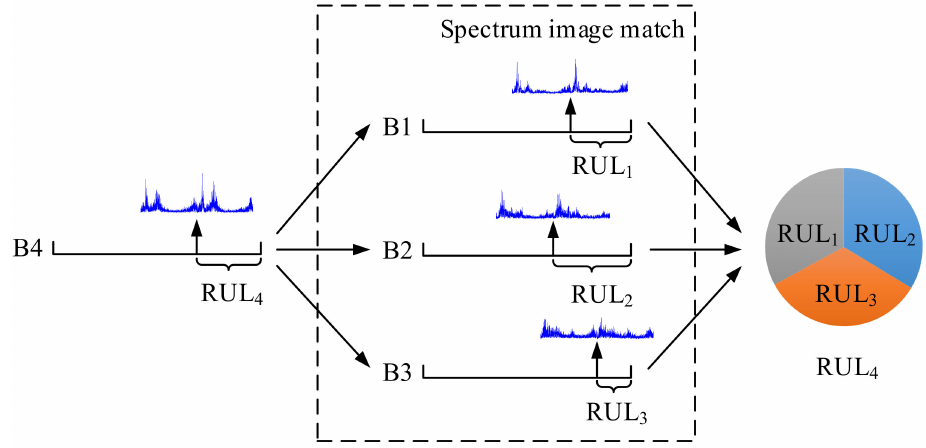
Figure 5. Schematic sketch of the RUL estimation